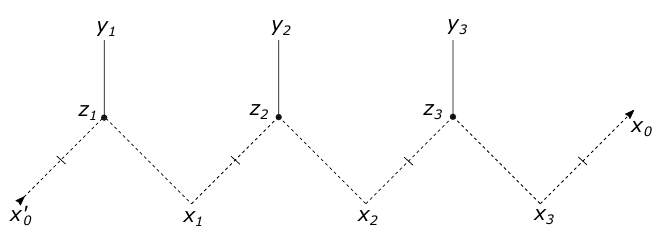
ˆ ( x | y ) for λ = − i . The solid lines Q (3) 0 , 1 ) 2 , the dashed lines stand for ( σ µ ( z − x ) ) / (( z − x ) 2 ) 2 while k − y k µ ) / (( x − z ) 2 ) 2 . The arrows denote the order of the µ